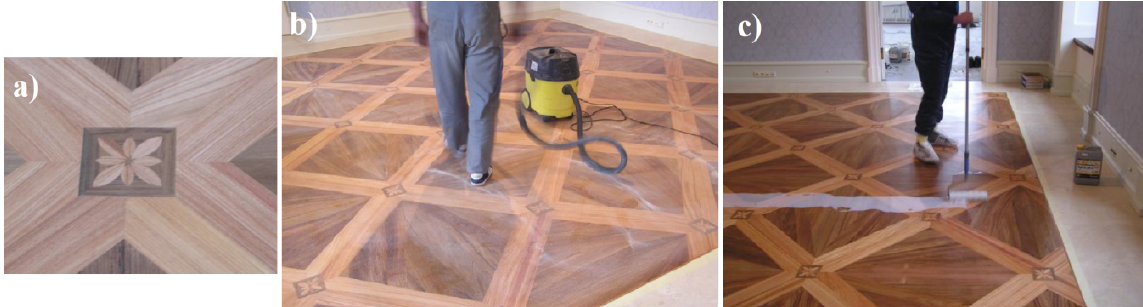
tractor made additional floor care using a matte preserva- tive to prolong the life of the floor without the necessary regeneration (Figure